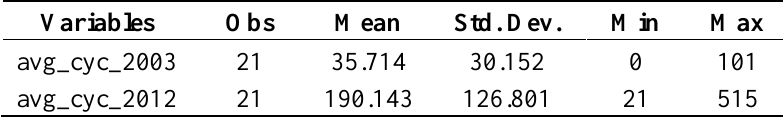
Table 2. Cyclist movement distribution across the time